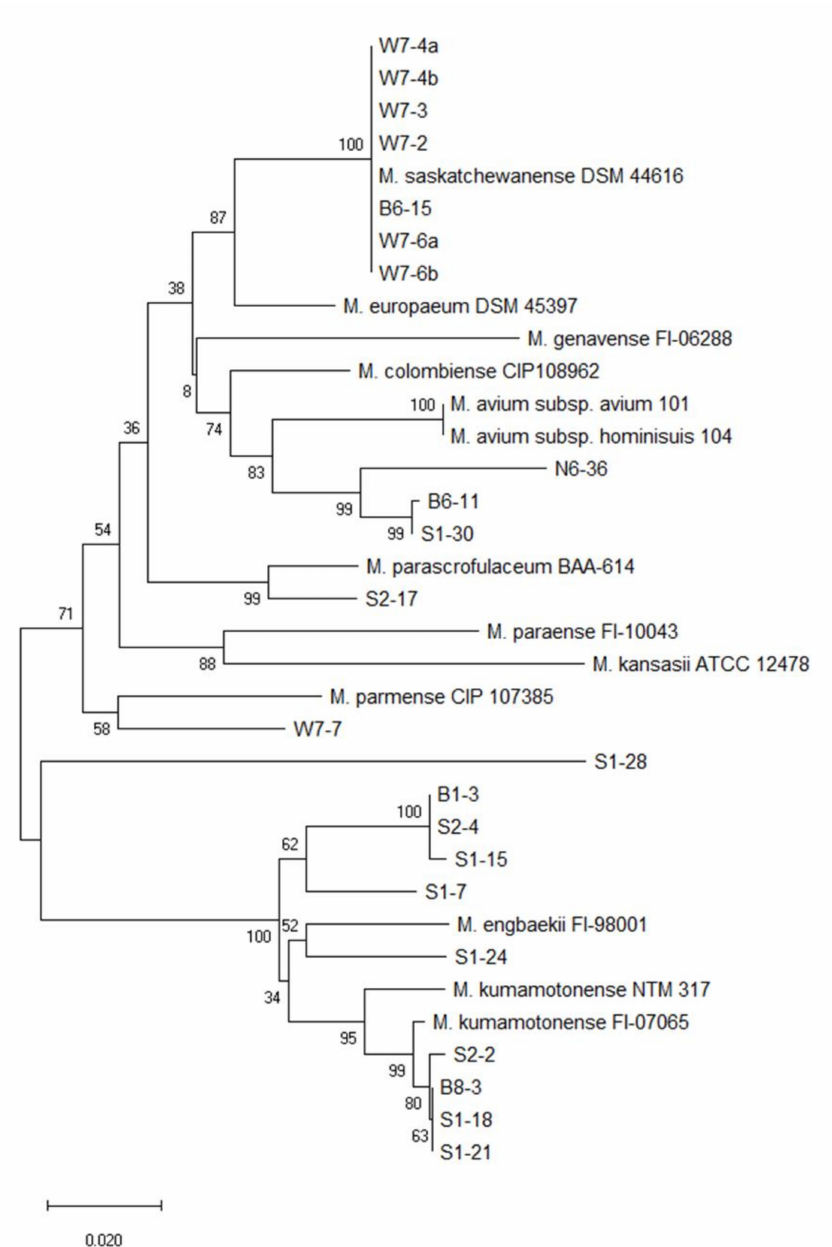
Figure 3. Phylogenetic analysis of non-MAC SGM isolates in South Korean soils based on the rpoB gene sequences of the isolates and previously reported strains in NCBI GenBank. The tree was created using the neighbor-joining method, and bootstrap analysis was performed from 1000